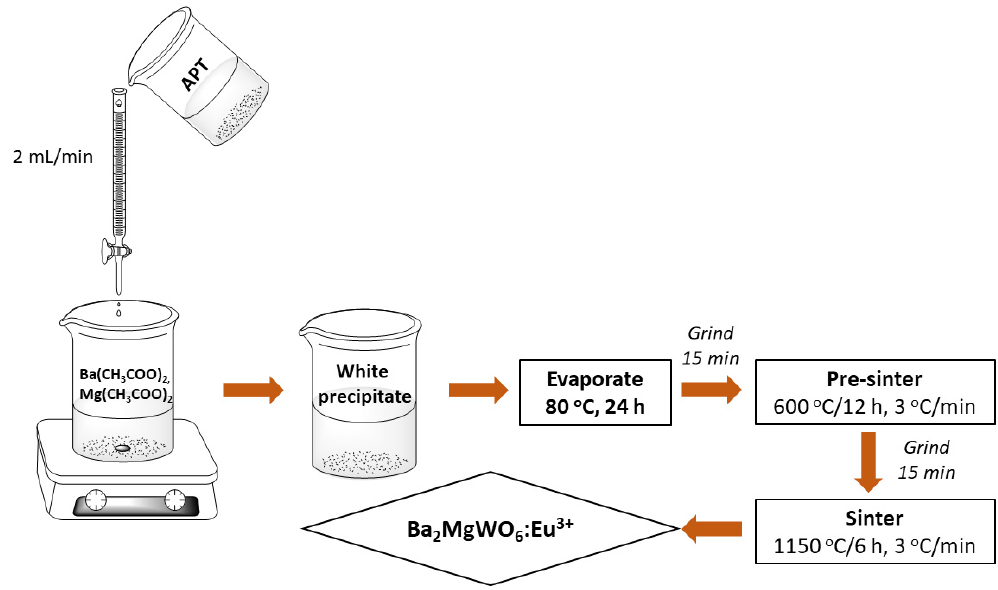
Figure 1. Scheme of Ba 2 MgWO 6 : Eu 3 + preparation using co-precipitation method.